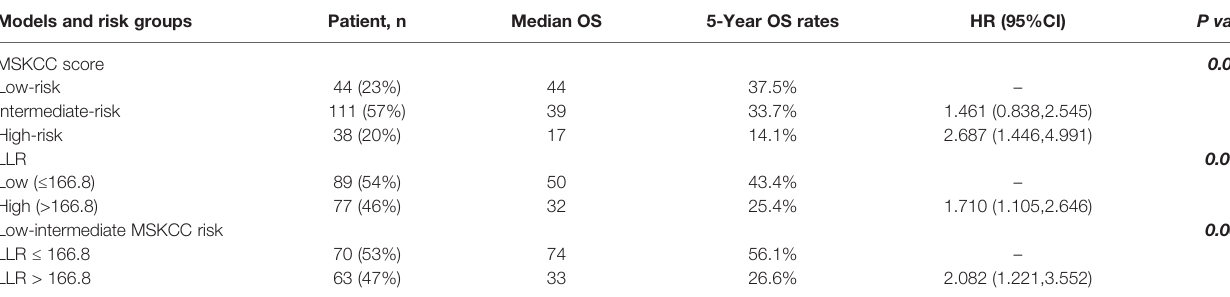
TABLE 5 | Survival outcomes of the assessable patients according to the different risk groups. Models and risk